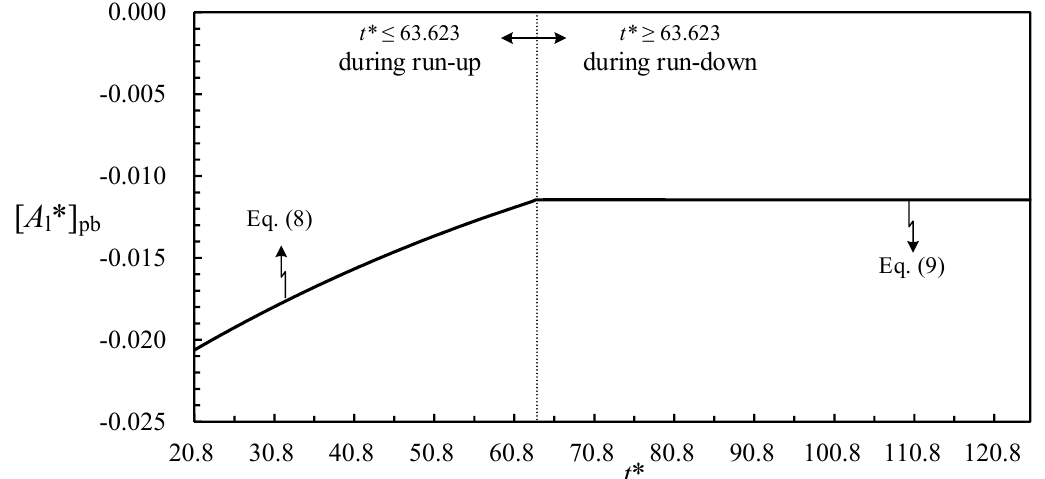
Figure 18. Relationship of non-dimensional local acceleration [ A l *( t* )] pb versus non-dimensional time t* for pure bore during run-up and run-down motions for 20.881 ≤ t* ≤ 63.623 and 63.623 ≤ t* < 125.284, respectively.